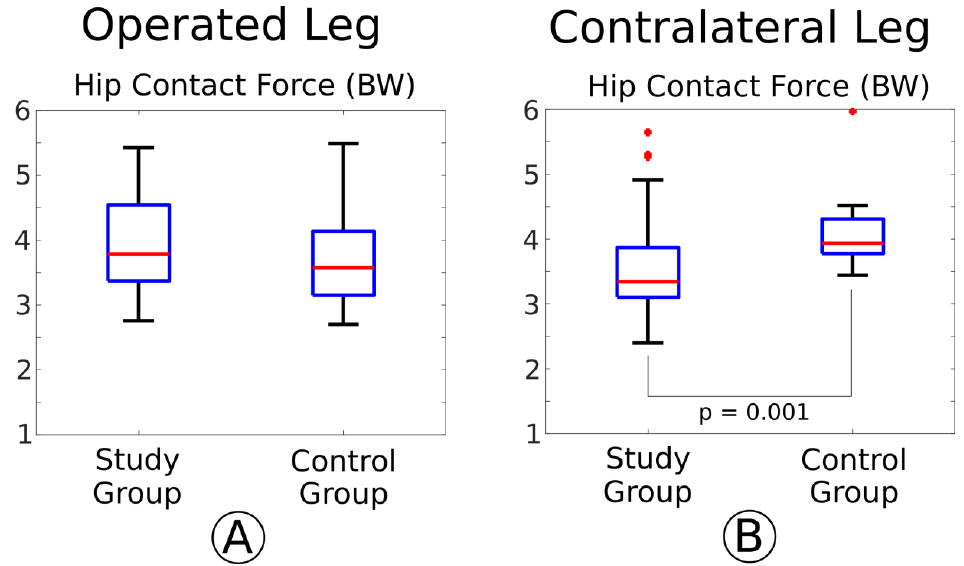
Figure 2. Boxplot distributions of the peaks of hip contact forces during gait compared between the Study and Control Groups, in the operated leg ( A ) and contralateral leg ( B ). P -values are reported for the significant differences between groups (Mann–Whitney U-test).